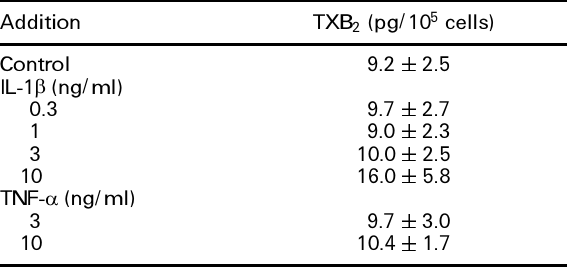
None of the values is signi® cant compared with control. n >